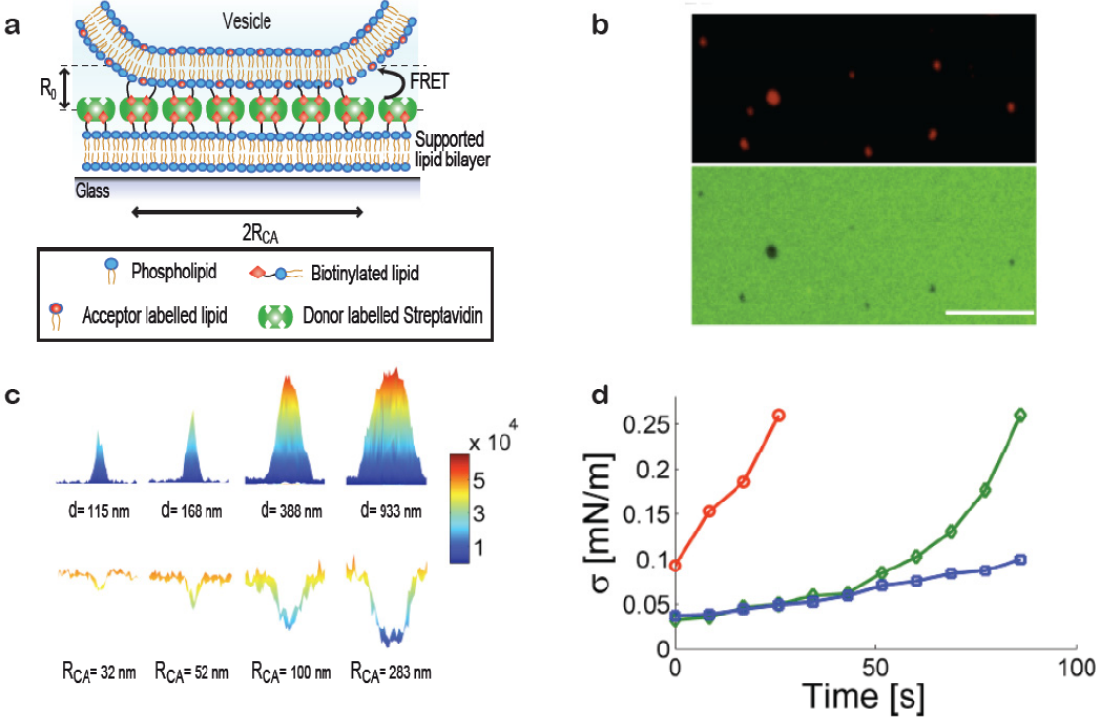
Figure 3. Measuring membrane tension on single vesicles by quantification of nanoscale contact areas formed between vesicles and a surface. (a) Sketch of the contact area formed between a vesicle and a streptavidin decorated supported bilayer. Quantitative information on the radius of the contact area (R ) was obtained by measuring FRET between donor CA dyes on the streptavidin layer and acceptor dyes in the vesicle membrane. R depicts the 0 Förster radius. (b) Fluorescence micrographs of vesicles with radius ≈ 100 nm (top) and the bilayer (bottom). FRET footprints are observed as a reduction in donor intensity. Bar: 5 µm. (c) Surface plots of fluorescence intensity of immobilised vesicles (top) and corresponding plots of fluorescence from the donor labelled streptavidin layer (bottom). By comparing theoretical and experimental results the degree of vesicle deformation upon immobilisation was evaluated. The obtained vesicle diameters, d, and the radii of the ) are indicated below the single vesicle intensity plots. mapped contact areas (R CA (d) Time-resolved measurements of single vesicle contact areas used to evaluate the tension in the bilayer as a function of time. In this example tension increased due to strong laser illumination [22]. The graph shows data for 3 vesicles of different size (circles; vesicle diameter d = 362 nm, diamonds; d = 778 nm and squares; d = 1,272 nm). Figure adapted from